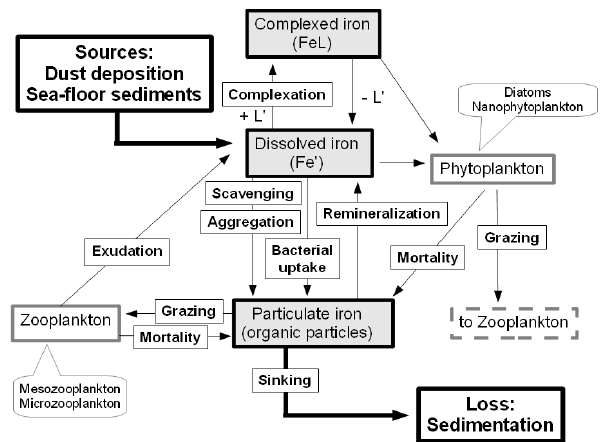
Fig. 3. Schematics of the iron cycle in PISCES as implemented in the current application (modified from Slemons et al., 2009). Fe’ indicates free inorganic dFe, L’ are ligands, while FeL indicates dFe complexed to